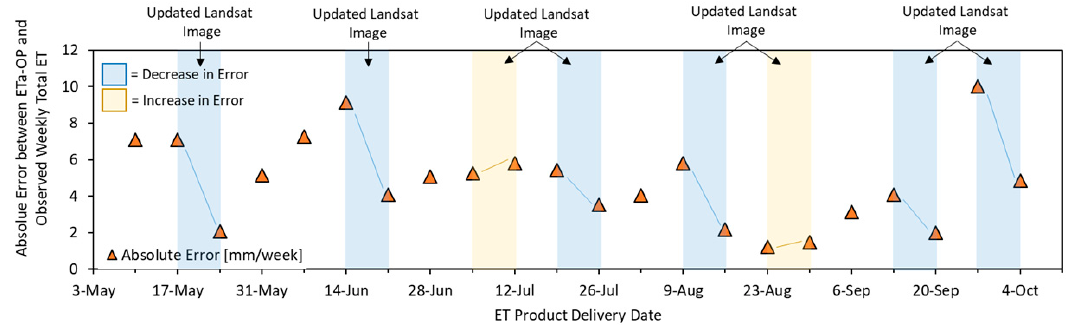
Figure 7. Time series of error (absolute difference; orange triangles) between ET a -OP derived weekly total ET a and observed weekly total ET a (closed) for each ET product delivery date (x-axis). Transparent boxes indicate a transition in ET product delivery date when there was an updated Landsat 8 image (blue = decrease in error over transition; yellow = increase in error over transition).